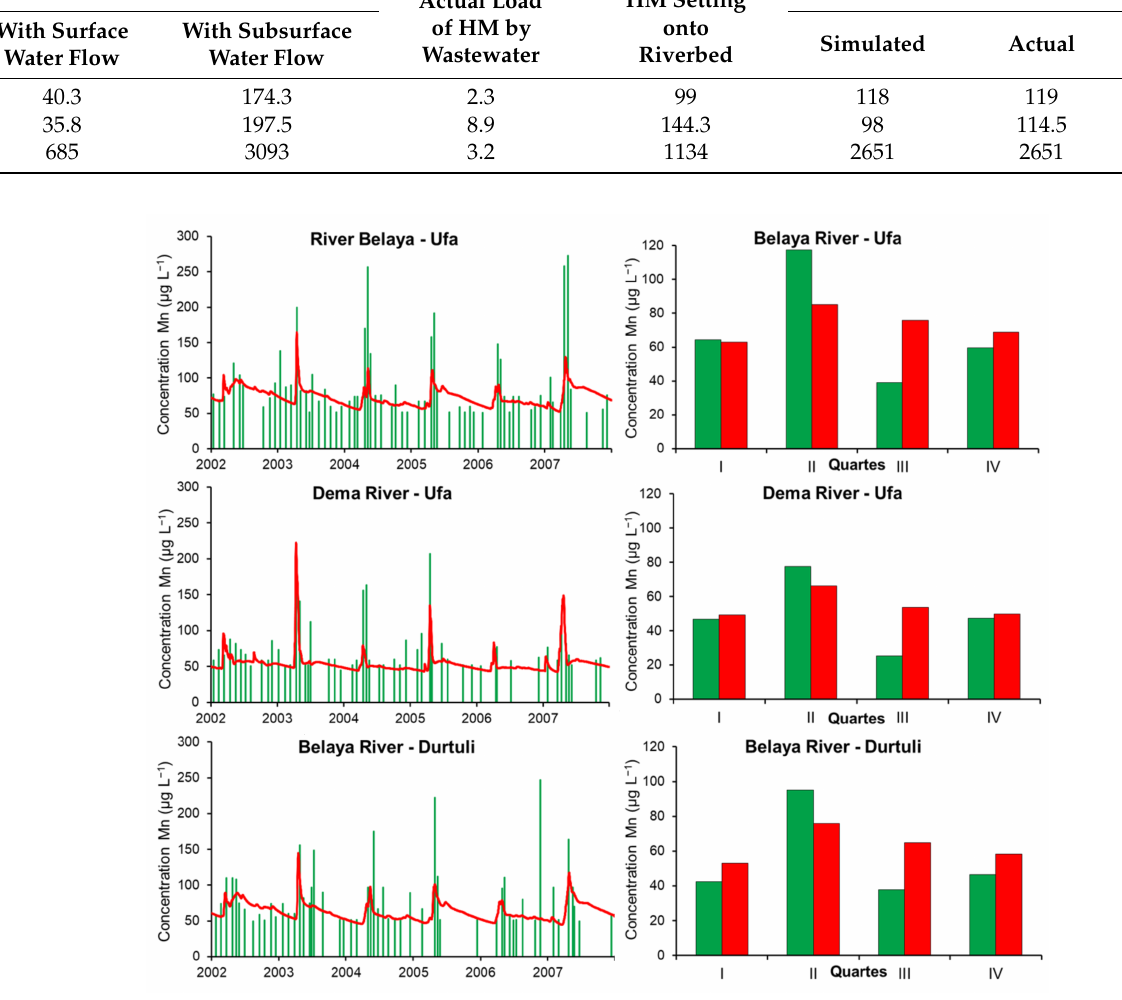
Figure 4. Observed (green) and simulated (red) Mn concentrations at certain hydrochemical monitor- ing points over the 2002–2007 period: On the left, the dynamics with daily resolution; on the right, the mean intra-annual concentrations by